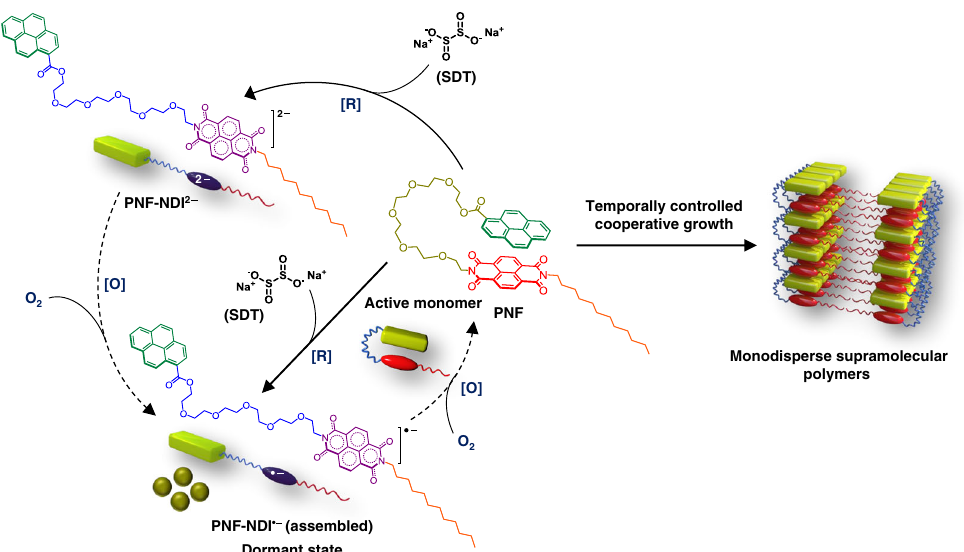
Fig. 1 Monomer design. Molecular structure of PNF charge-transfer foldamer and the schematic representation of its amphiphilic assembly into one- dimensional supramolecular polymers by lamellar organization of the bilayers. Kinetically controlled pathway of PNF assembly involves the generation of unfolded PNF-NDI (cid:129) − and PNF-NDI 2 − as dormant states for the monomers using sodium dithionite (SDT) as reducing agent and its subsequent temporal oxidation reversibly regenerate the active PNF foldamers in a controlled manner that undergo a kinetically controlled growth. [R] and [O] represents reduction and oxidation processes, respectively. Temporally controlled growth of PNF via redox-dormant pathways results in highly monodisperse supramolecular polymers.